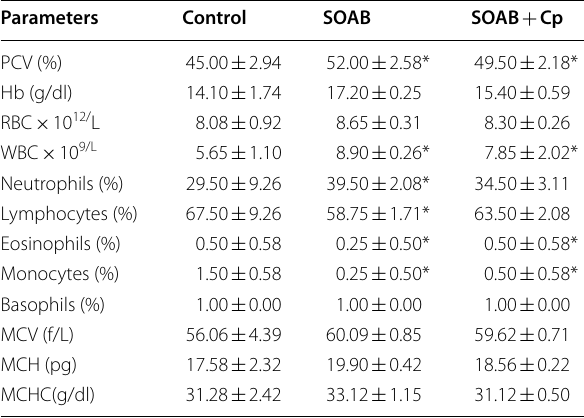
Data are expressed as Mean SD ± Hb hemoglobin; HCT hematocrit; PCV packed cell volume; RBC red blood cell; MCV mean corpuscular volume; MCH mean corpuscular hemoglobin; MCHC mean corpuscular hemoglobin concentration; WBC white blood cell; SOAB Sesamum indicum oil based nanoemulsion; SOAB Cp Ciprofloxacin-loaded + Sesamum indicum oil based nanoemulsion *Values are statistically different at p < 0.05 for each experimental groups compared to the control group